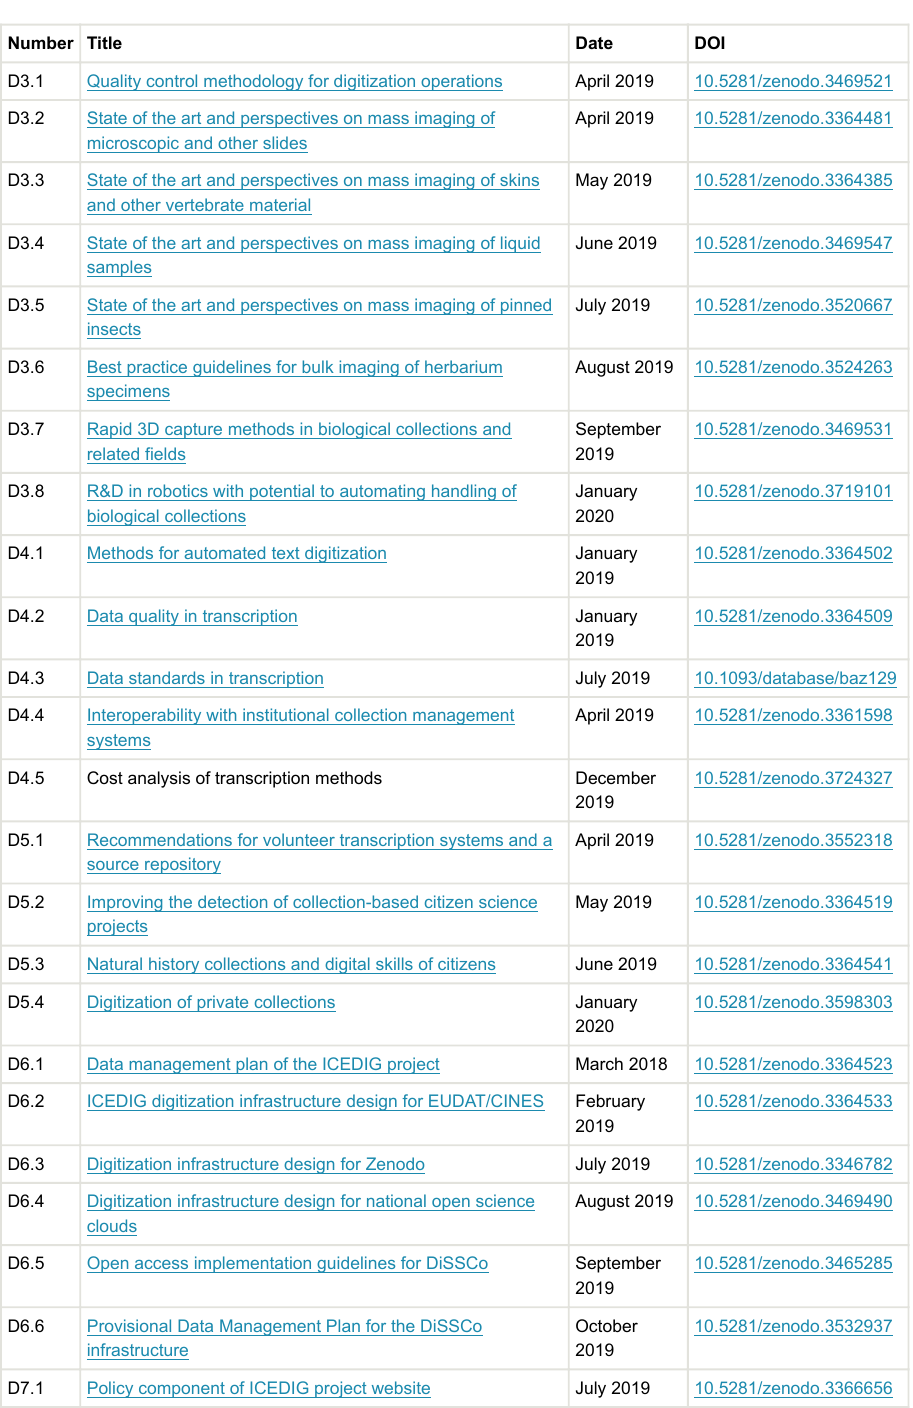
Conceptual design blueprint for the DiSSCo digitization infrastructure